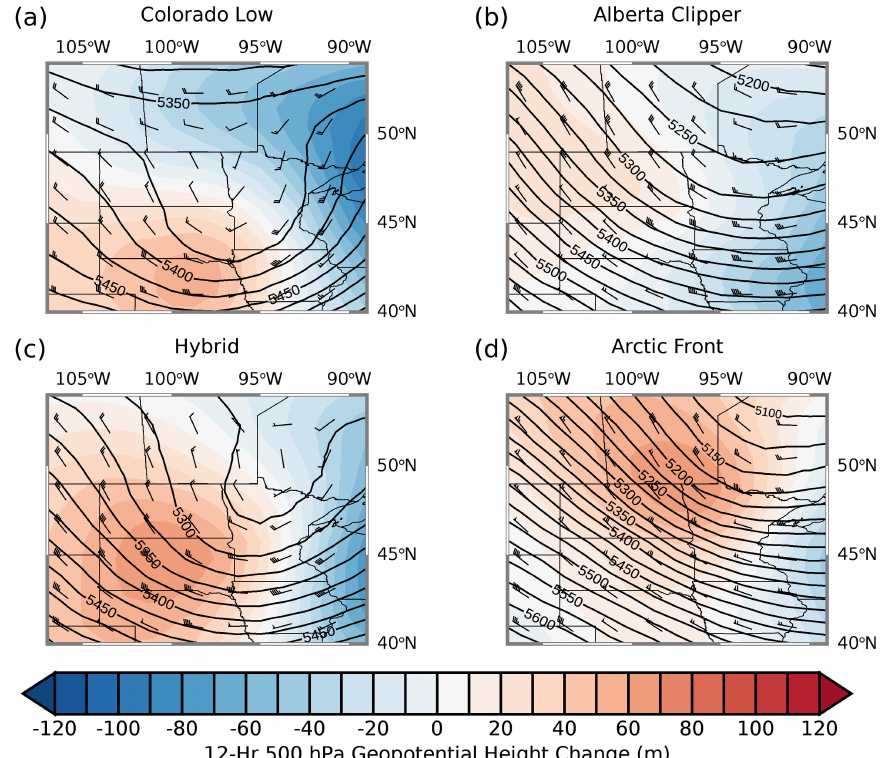
Figure 7. As in Figure 5, except for the midpoint of the blizzard. 12-h 500 hPa height change (12 hr post—midpoint) is provided by shaded contours.